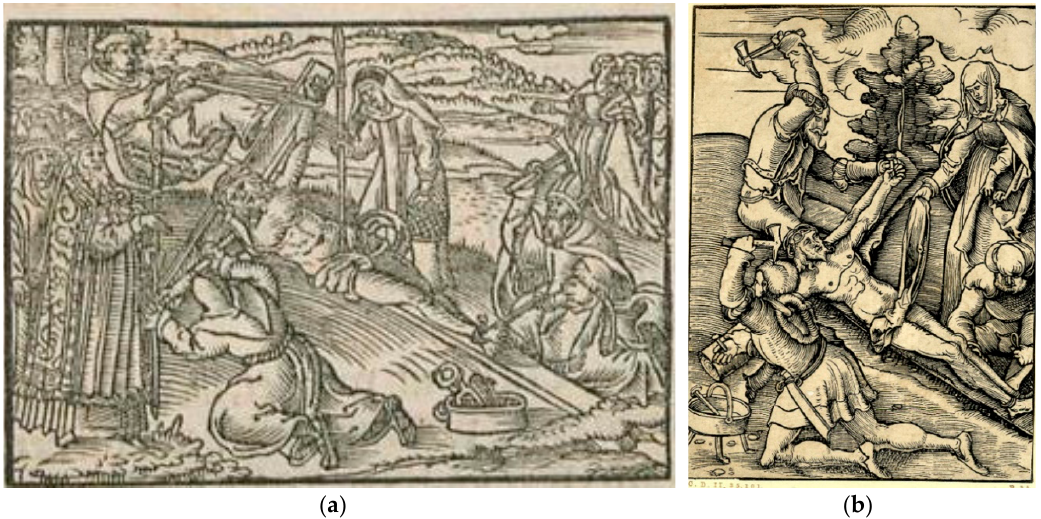
Figure 11. Christ nailed to the cross : ( a ) woodcut recurring in books published by vom Berg and Neuber [R 28], in (Luther 1545a), fol. CLVIv (Halle, Salle, Universitäts- und Landesbibliothek Sachsen-Anhalt, urn:nbn:de:gbv:3:1-102424); ( b ) Monogrammist IS with a shovel, London, the British Museum, asset number 85418001, © The Trustees of the British Museum.